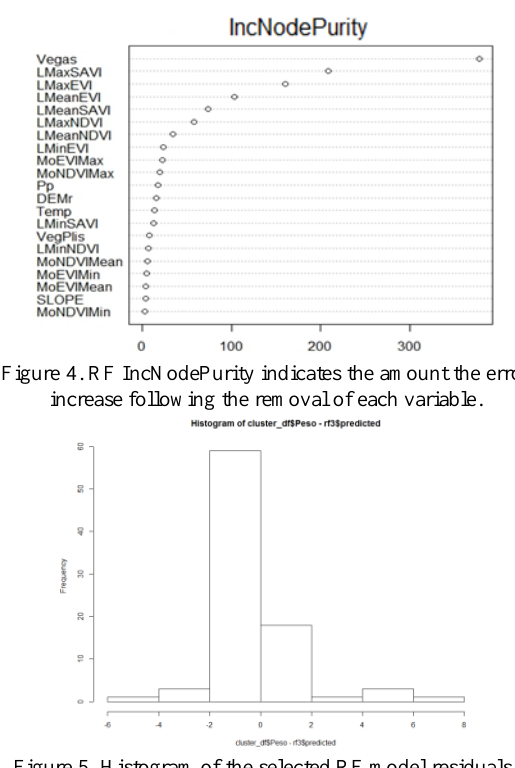
Figure 5. Histogram of the selected RF model residuals.